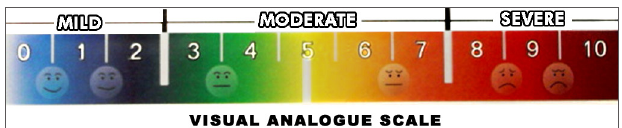
Figure 3. Visual-analogue scale used for nasal